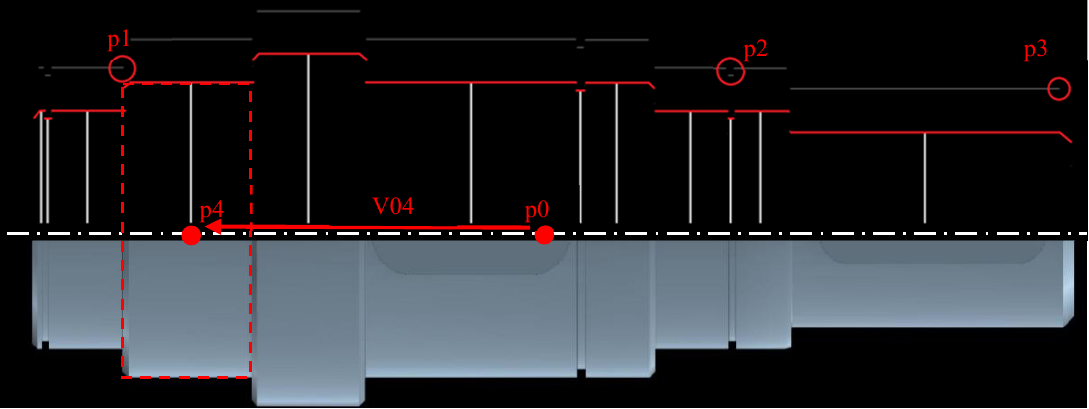
Figure 4. Accurate measurement of characteristic parameters by the image-processing algorithm.